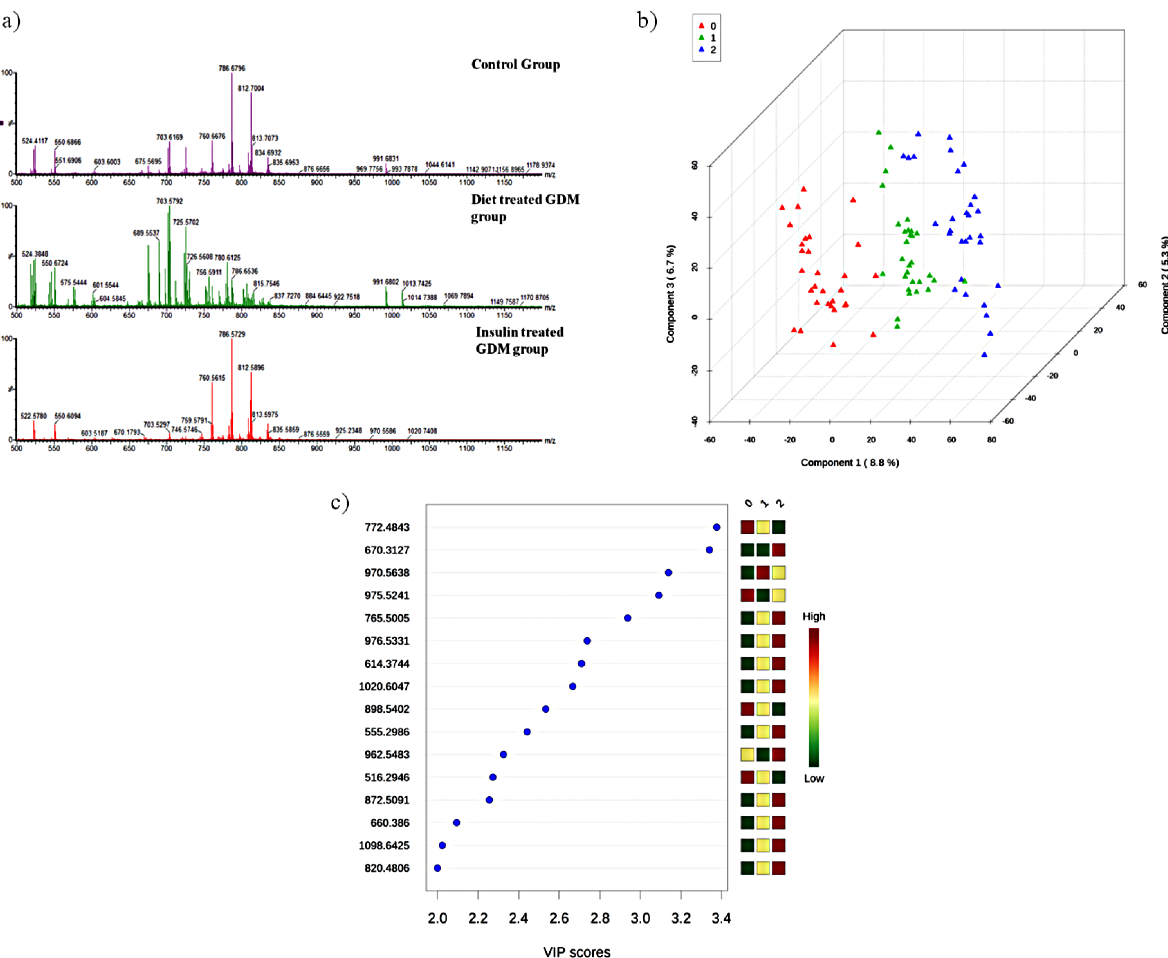
Fig 1. Serum lipid profile of healthy pregnant women and women with milder and more severe forms of GDM. ( A) ESI-MS characteristic spectra of healthy controls, diet-treated GDM and insulin- treated groups. (B) 3D score plot between the selected principal components. (C) Important features identified by PLS-DA. The colored boxes on the right indicate the relative concentrations of the corresponding metabolite in each group under study. Group 0 = Control; Group 1 = Diet-treated GDM; Group 2 = Insulin-treated GDM.